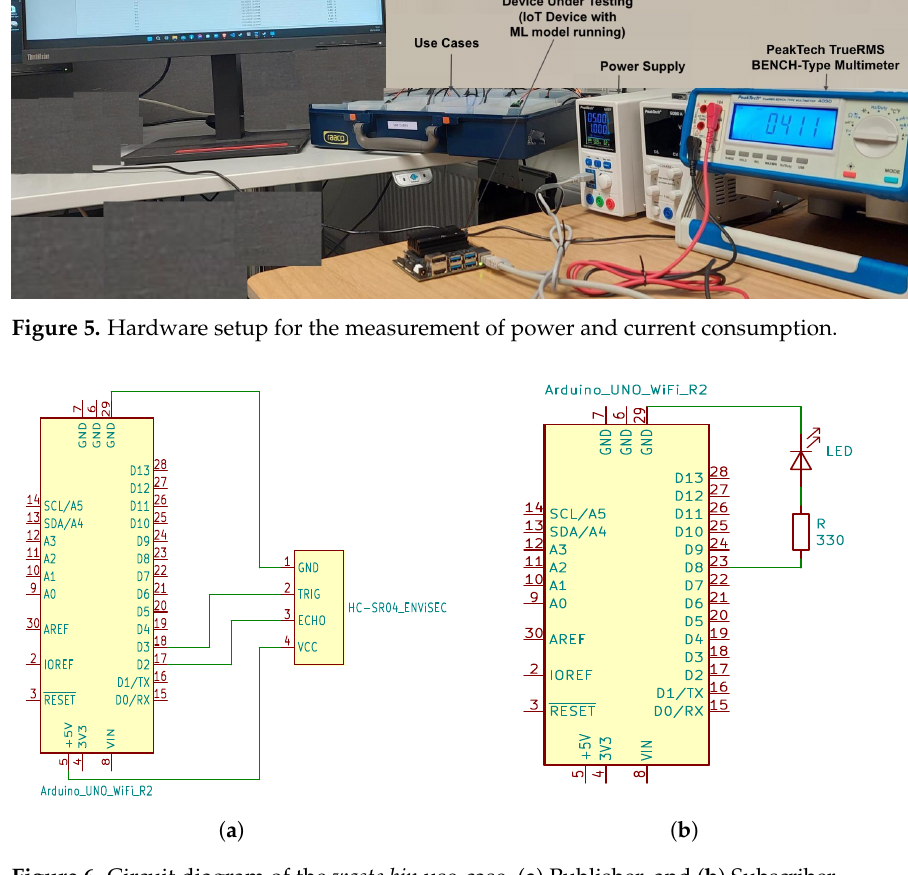
Figure 6. Circuit diagram of the waste bin use-case, ( a ) Publisher, and ( b ) Subscriber.